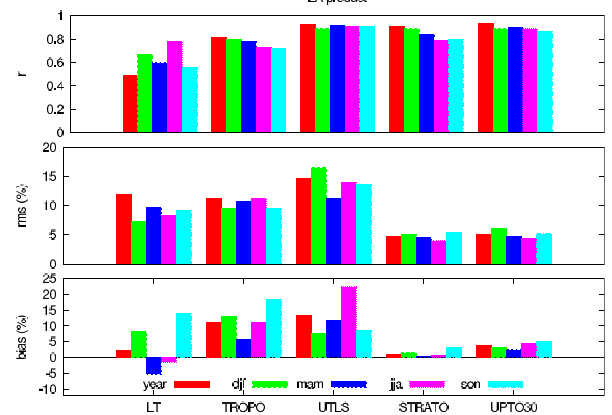
Fig. 8. Same as Fig. 6 for the LISA product.